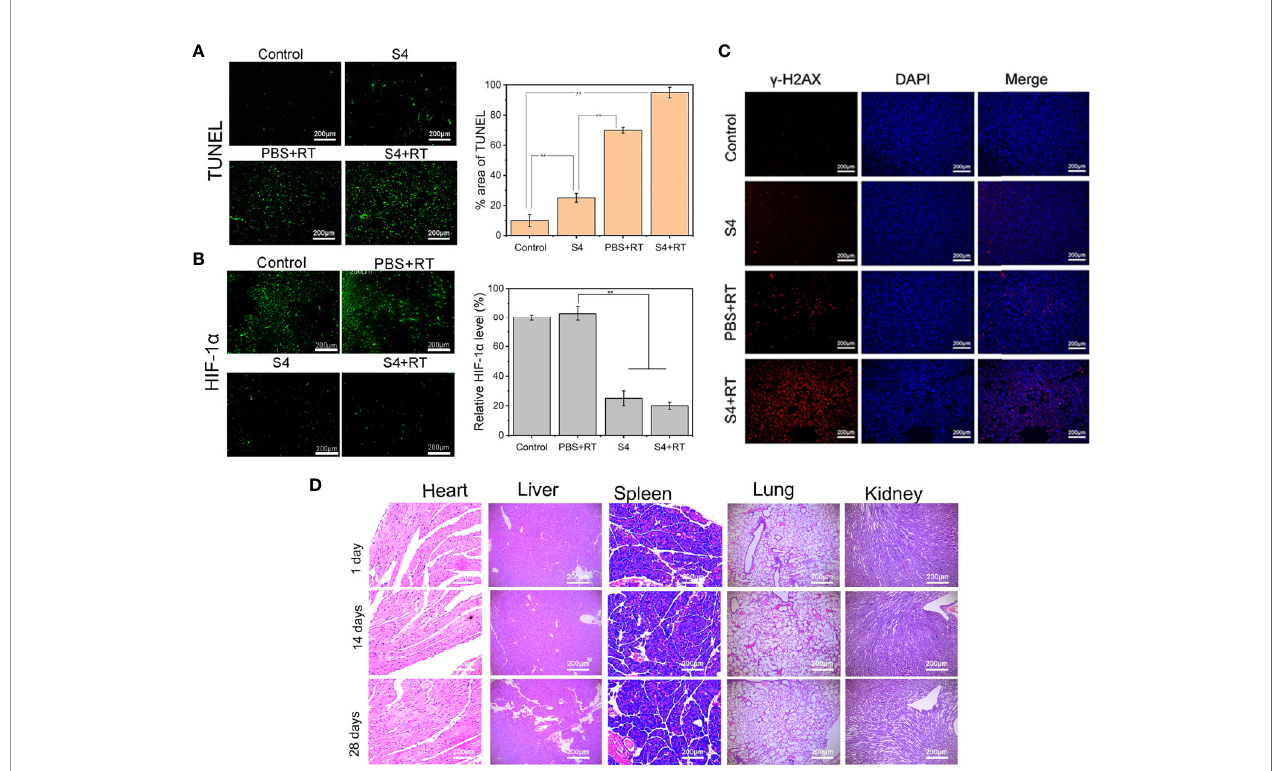
FIGURE 6 | Effect of S4 treatment plus irradiation on apoptosis, hypoxia, and DNA in vivo. Mice inoculated with ECA-109 cells were divided into four groups (n=5 per group): control (PBS vehicle), S4 (S4 treatment), PBS+RT (PBS vehicle plus X-ray irradiation at 4 Gy), and S4+RT (S4 treatment plus X-ray irradiation at 4 Gy). Tumor samples were collected at the end of the study (death or at day 28 post-treatment). Tumor samples were sectioned and stained for (A) TUNEL reagent (apoptosis), (B) HIF-1 a (hypoxia), and (C) g -H2AX and DAPI (DNA damage). (D) Heart, liver, spleen, lung, and kidney tissues were harvested from the S4+RT group at days 1, 14, and 28 following treatment and examined for histopathological changes by H&E staining. ** P <